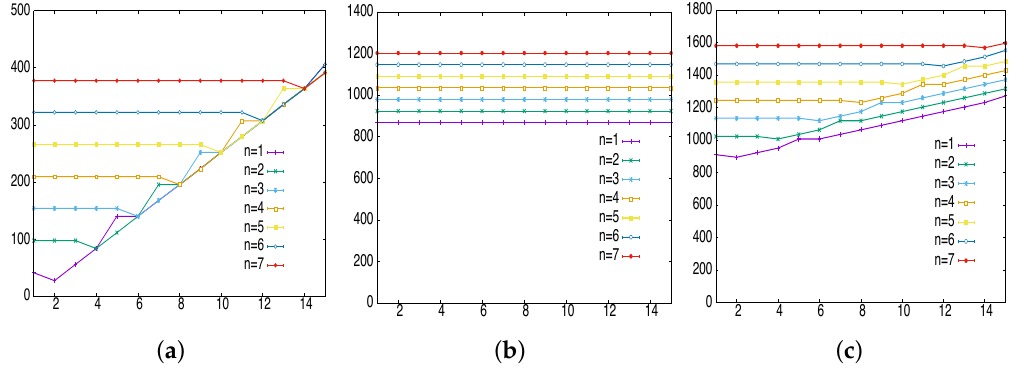
Figure 2. Simulation results in static markets with naive DA mechanism. ( a ) Buyers’ surplus; ( b ) Buyers’ resale profit; ( c ) Buyers’